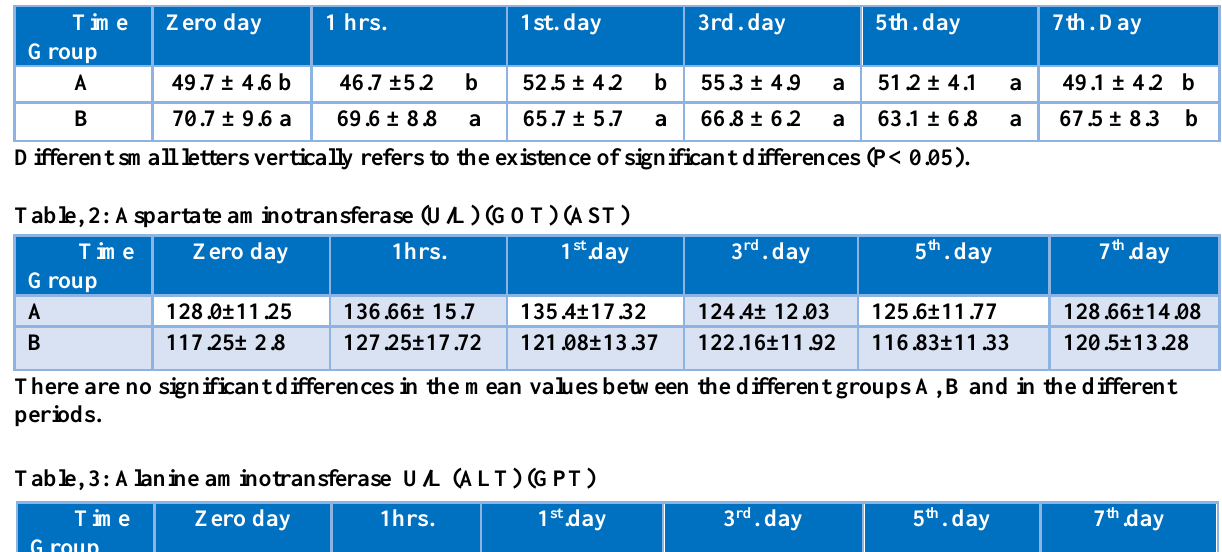
Table, 1: Alkaline phosphates (U/L) (ALP)